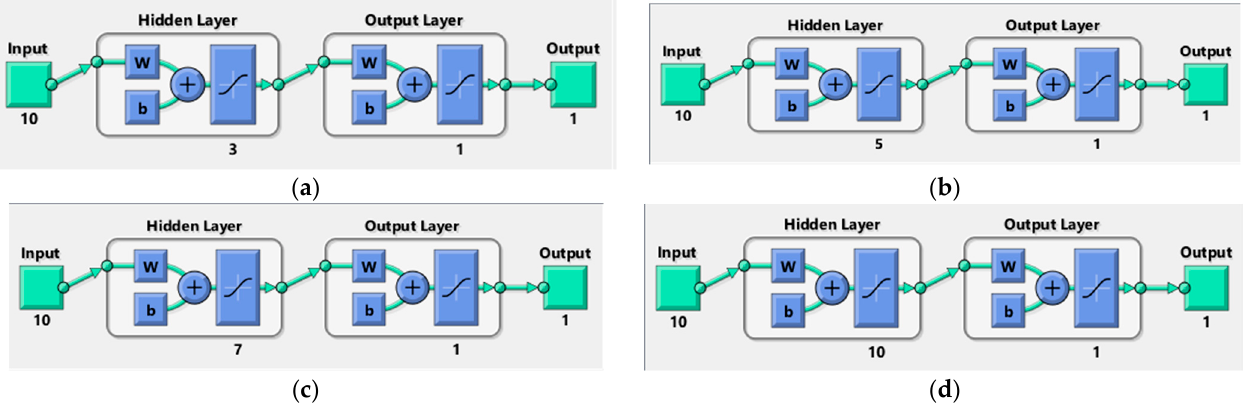
Figure 17. The architecture of ANN models for prediction compressive and tensile strength ( a ) 3 neurons, ( b ) 5 neurons, ( c ) 7 neurons and ( d ) 10 neurons ( a ) 3 neurons, ( b ) 5 neurons, ( c ) 7 neurons and ( d ) 10 neurons.